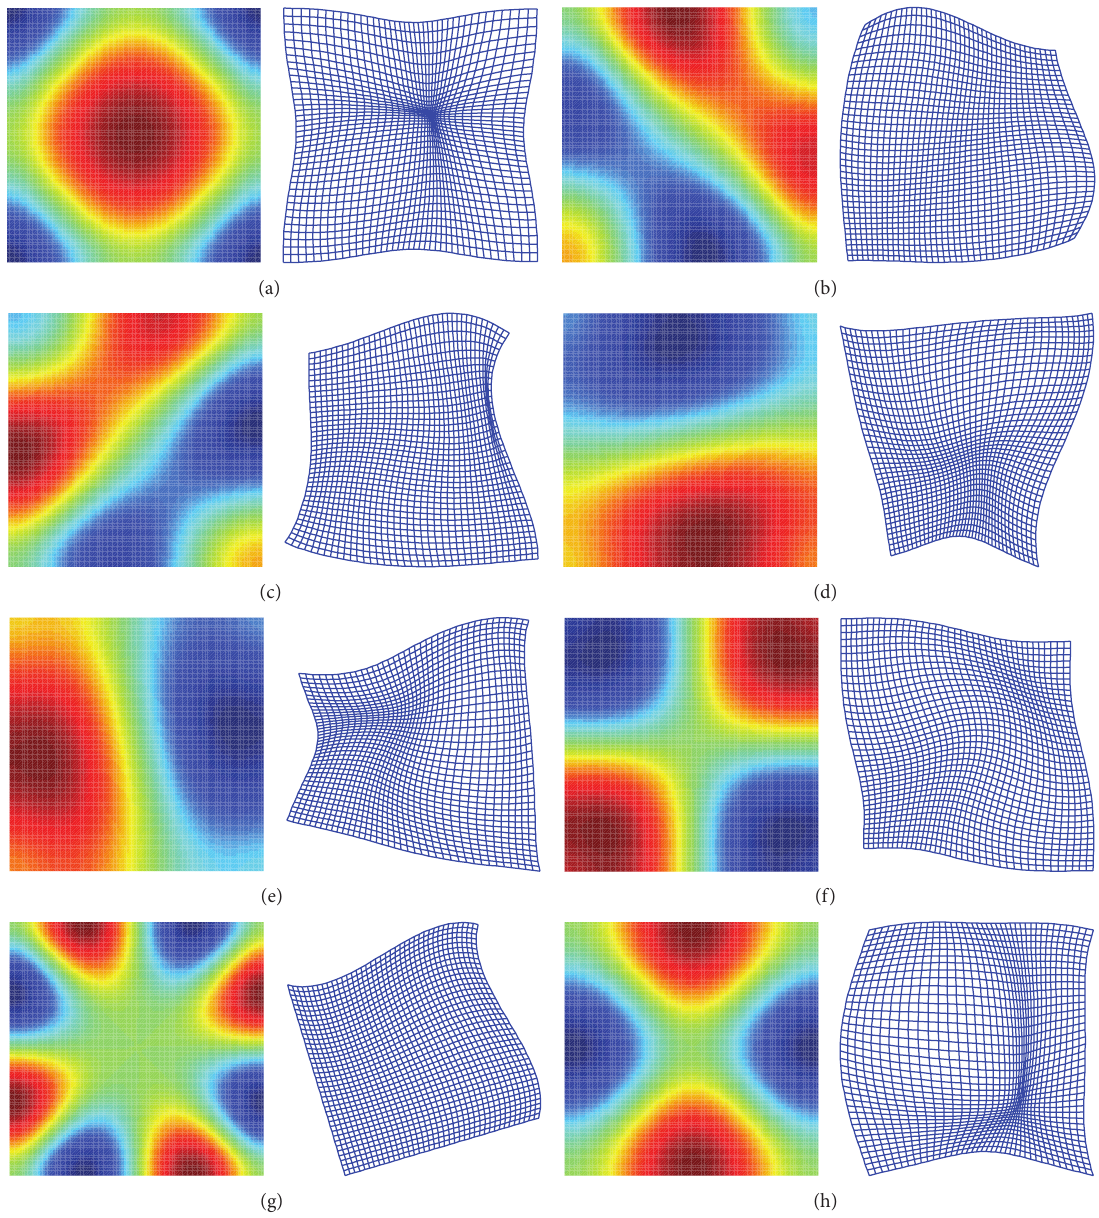
Figure 4: The mode shapes (left: out-of-plane mode shapes; right: in-plane mode shapes) for a doubly curved shallow shell with elastic restraints, 𝑘 = 10 6 and 𝐾 = 10 7 , along each edge. The (a) first, (b) second, (c) third, (d) fourth, (e) fifth, (f) sixth (g) seventh, and (h) eighth